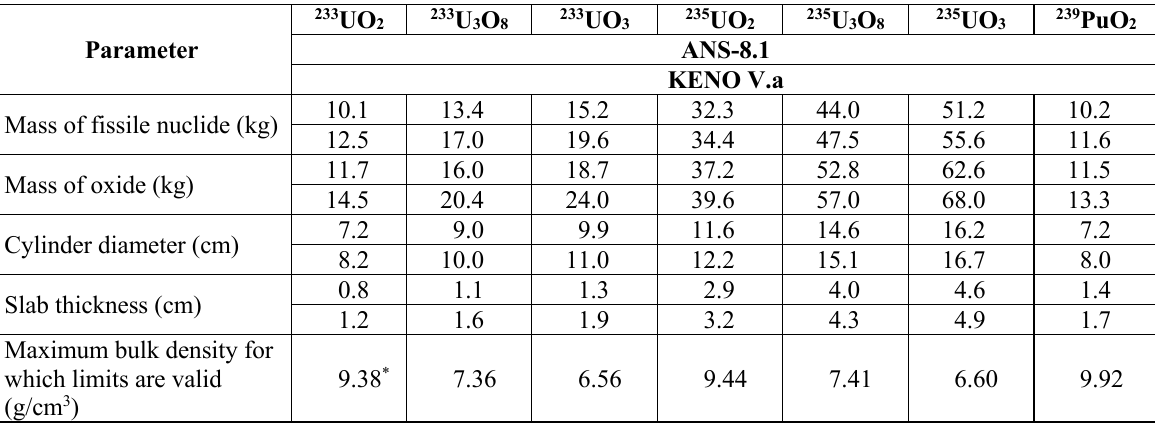
Table IV. Single-parameter SCLs for oxides containing no more than 1.5% water by weight at full density.